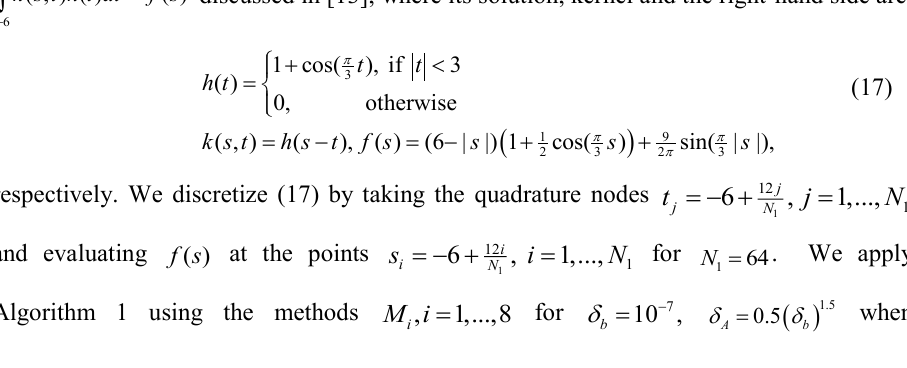
Algorithm 1 using the